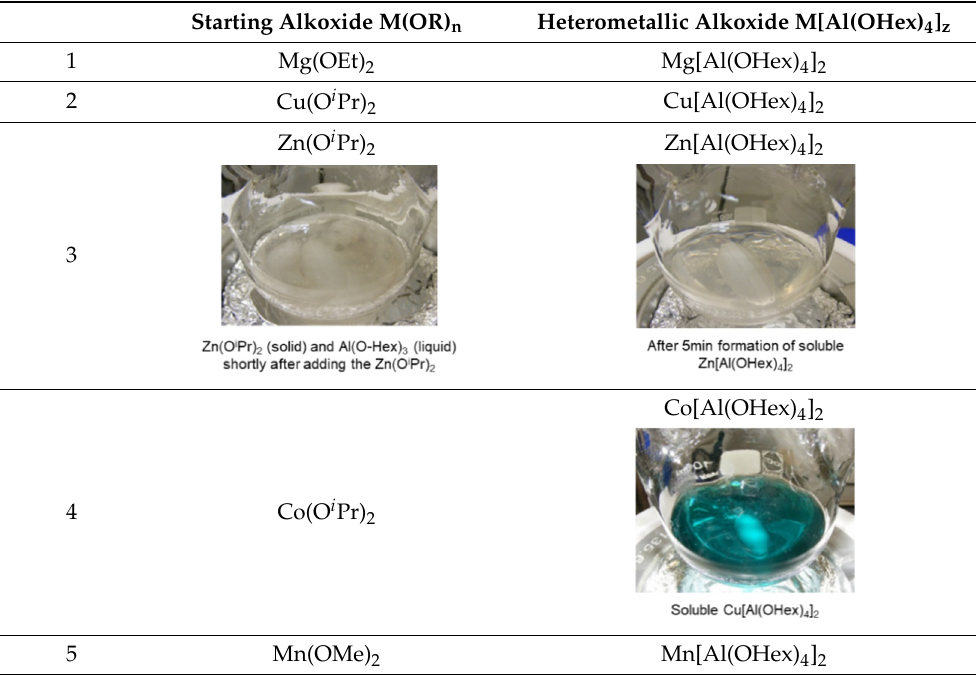
heating the samples to reflux temperature of 1-hexanol, a homogeneous slightly colored solution was formed with all heterometallic compositions shown in Table 2. Table 2. Heterometallic alkoxides, n [M(OR) 2 ] = 30 mmol, n [Al(OHex) 3 ] = 60 mmol and n [1-hexanol] = 300 mmol. All compositions are formed 5–10 min after reaching T = 353 K. Photographs are shown exemplarily.